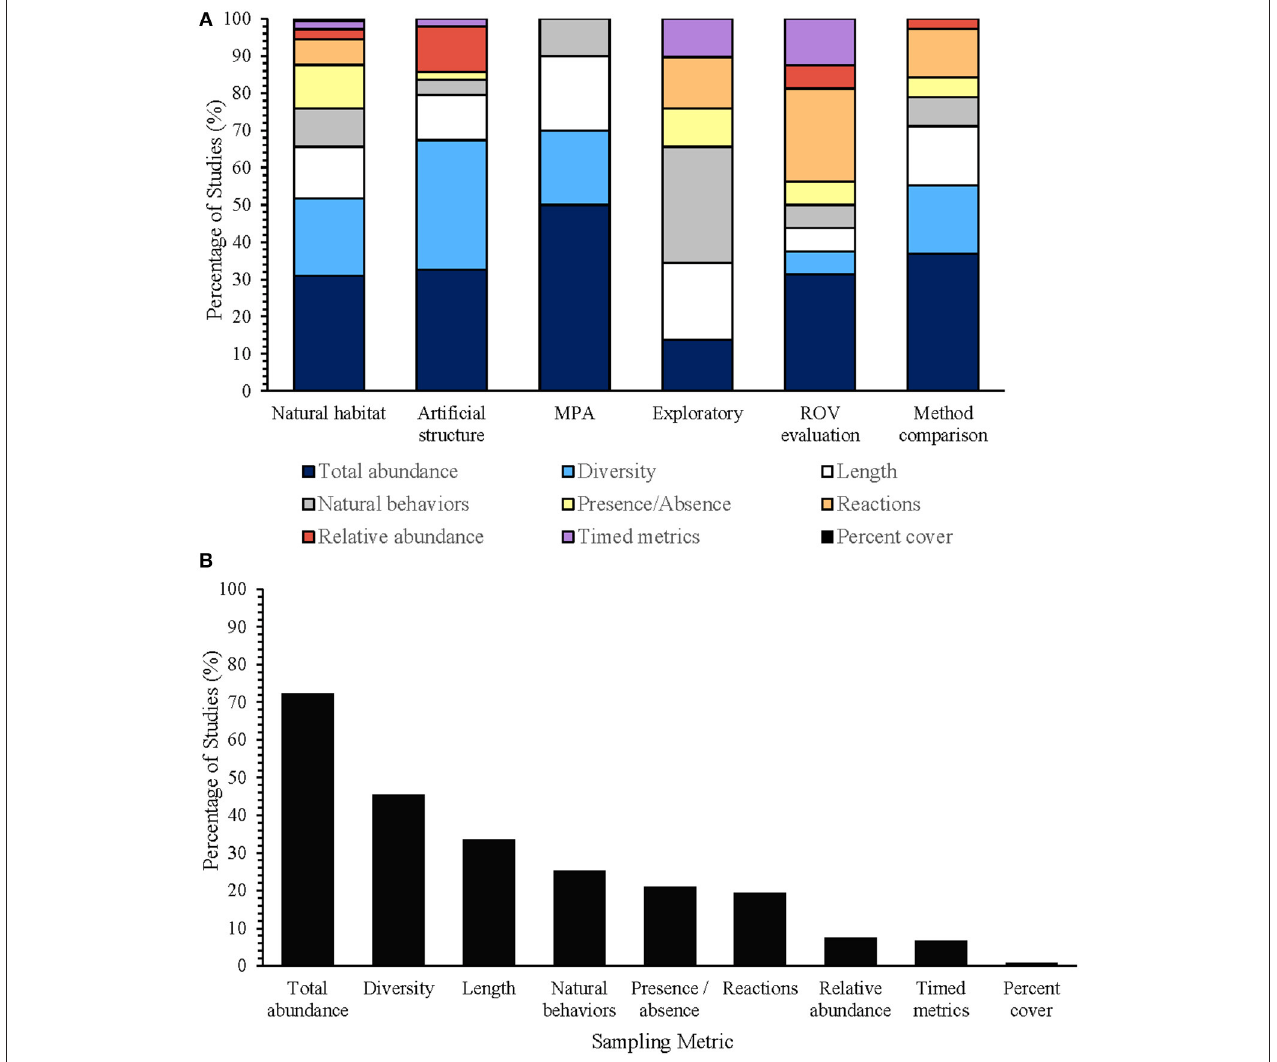
FIGURE 8 | The percentage of studies using each sampling metric for fish population assessments in natural habitats ( n = 62 publications), for population assessments on artificial structures ( n = 19 publications), for studies in marine protected areas (MPAs) ( n = 5 publications), for exploratory studies without the use of standardized transects ( n = 15 publications), for studies evaluating the effectiveness of ROV methodology ( n = 7 publications), and for studies comparing ROVs against other surveying methodology ( n = 15 publications) (A) , and the percentage of studies using each sampling metric to annotate video footage in surveys ( n = 119 publications) (B)